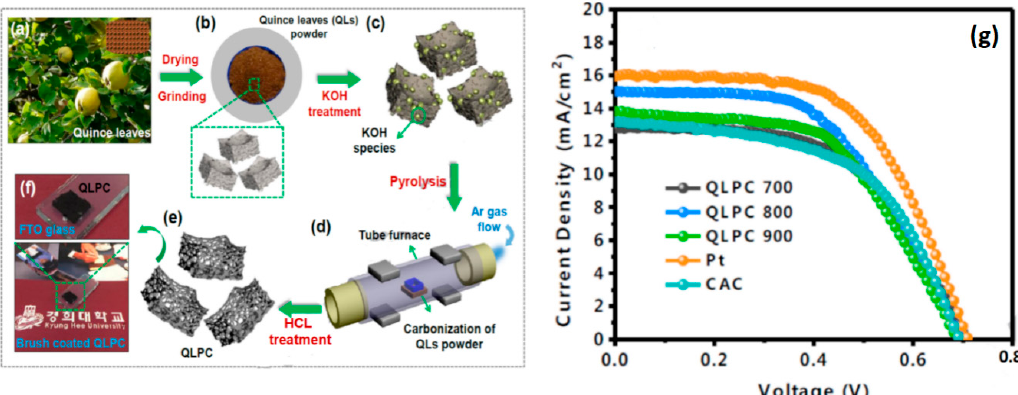
Figure 11. Schematic diagram showing the importance of porous carbon nanostructures as high-efficiency CEs in DSSCs.